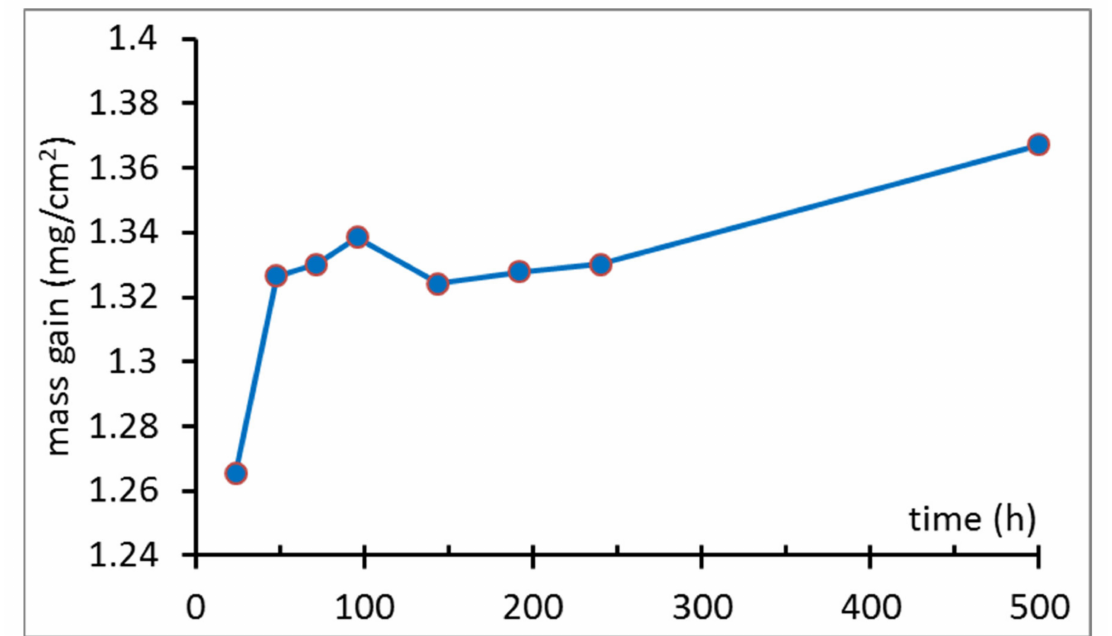
Figure 1. Mass gain after steam oxidation at 700 ◦ C.